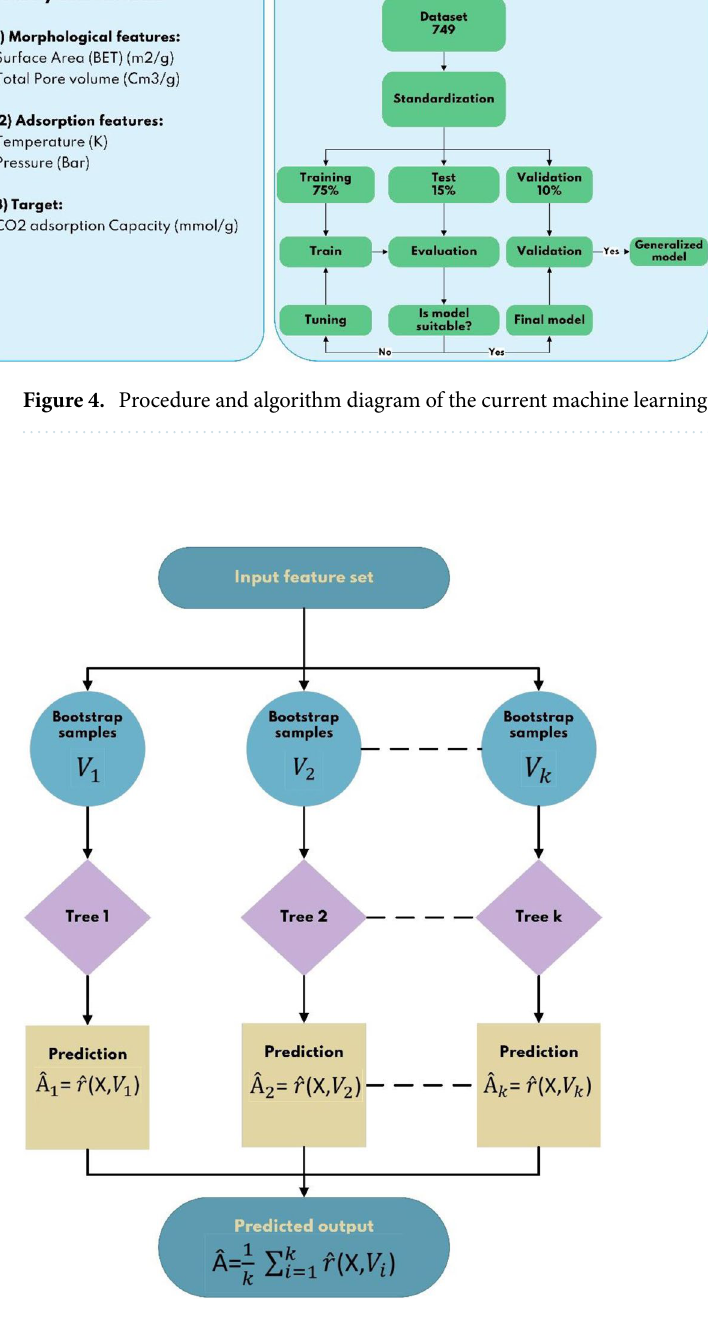
Figure 5. Schematic diagram of random forest